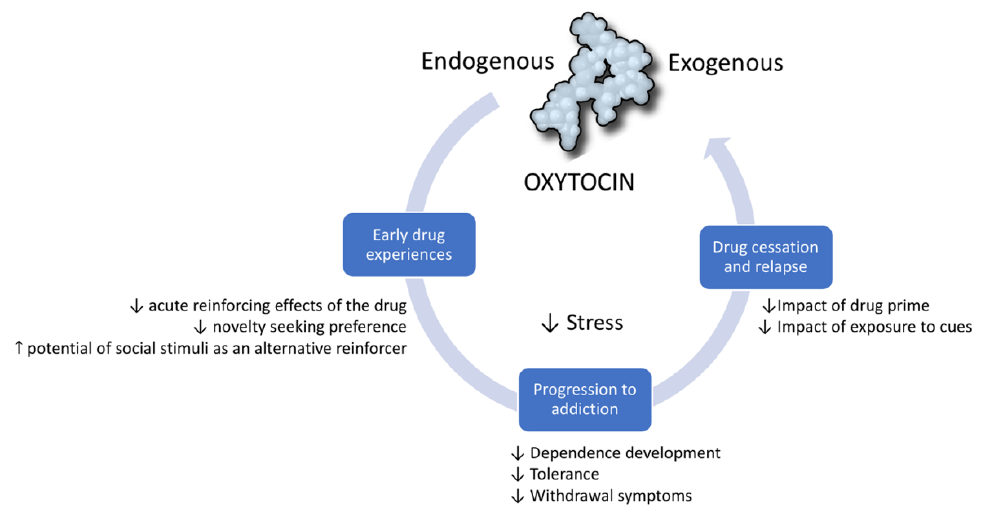
Figure 1. Oxytocin modulates the addiction cycle. Clinical and preclinical studies show that oxytocin has protective effects during all stages of the addiction cycle: (1) In early drug experiences, it diminishes the reinforcing and general effects of drugs. (2) It can prevent progression from initial drug experimentation to dependence and drug escalation. (3) In drug cessation, it can prevent relapse induced by cues, drug primes, and stress.